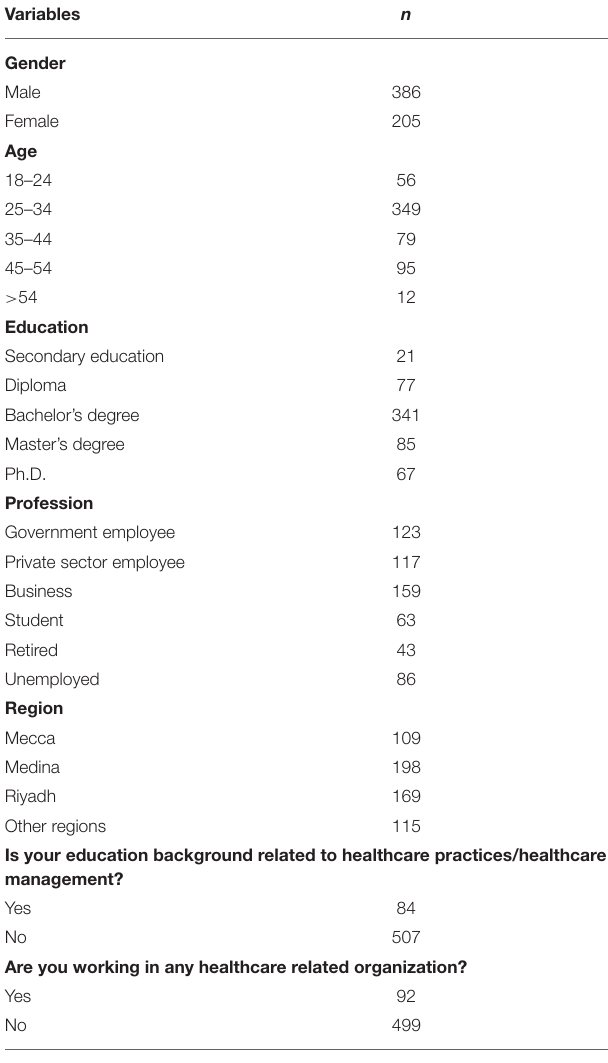
TABLE 1 | Frequency distribution of demographic